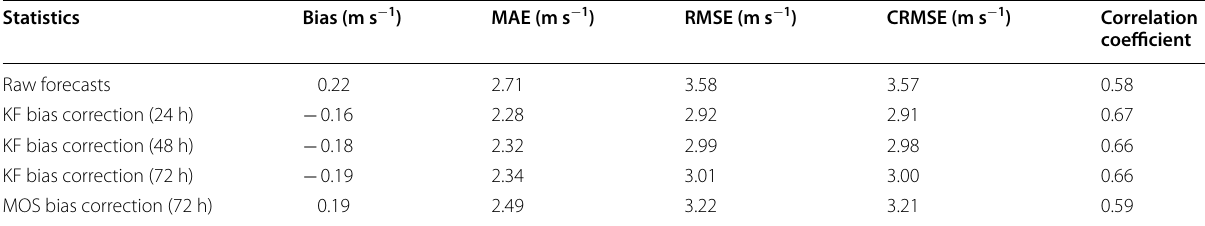
Table 1 The overall performance of the KF bias correction for 24-h, 48-h, 72-h forecasts and MOS bias correction for 72-h forecasts based on the five metrics (bias, MAE, RMSE, CRMSE, and correlation